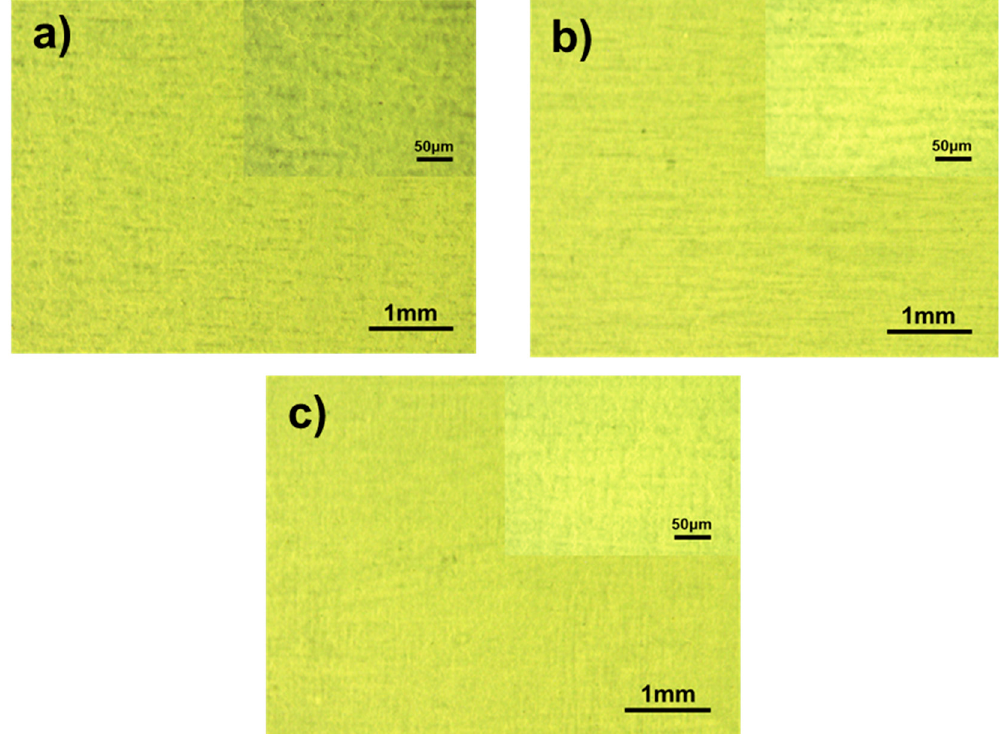
Figure 16. Images of h-BN coatings annealed at 400 ( a ), 600 ( b ) and 800 °C ( c ).